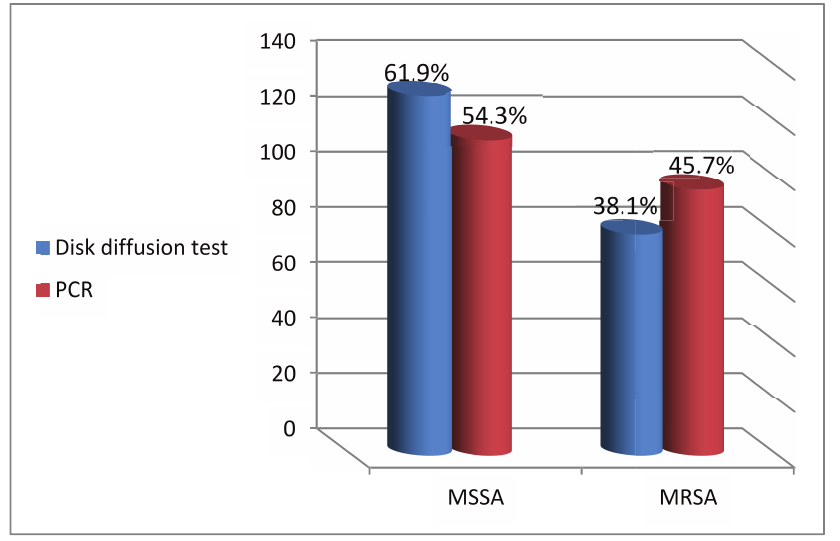
Figure 1: Number and percentage of detected MRSA and MSSA strains by disk diffusion and PCR ( mecA